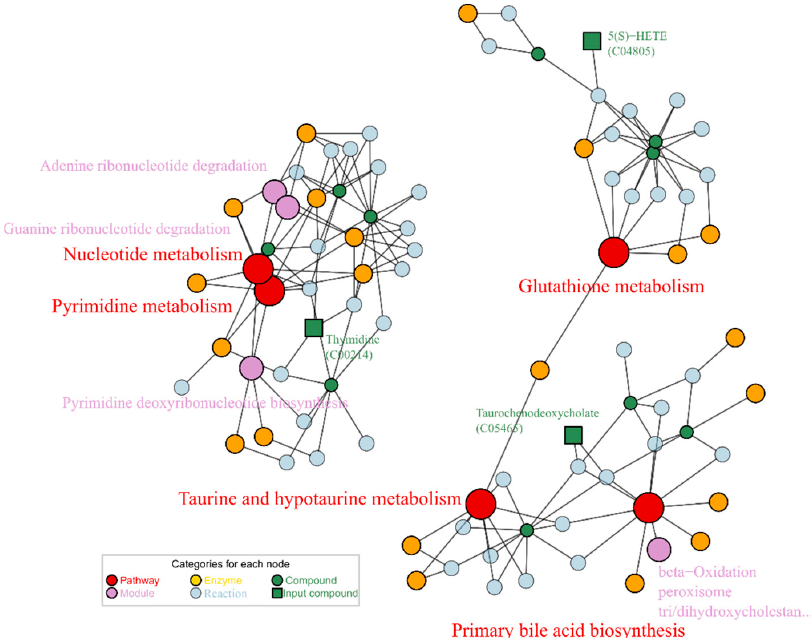
Figure 8. Enriched map based on repaired metabolites by lotusine, enrichment p score < 0.01.